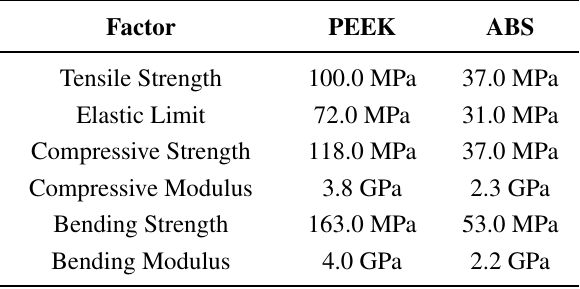
Table 2. Mechanical properties of PEEK and acrylonitrile butadiene styrene (ABS).